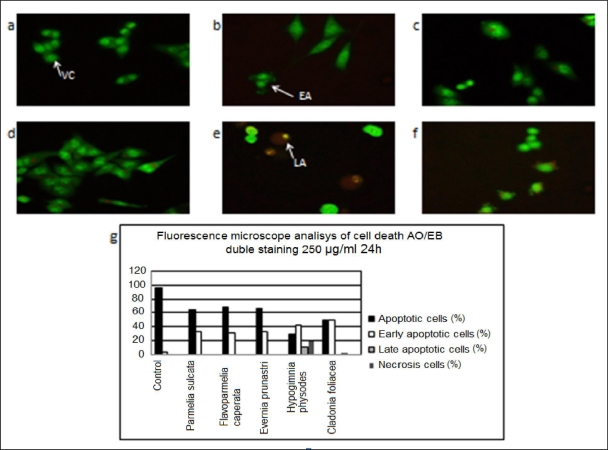
The effect of the lichen extracts on the apoptosis of HCT-116 cells after 24 h exposure monitored by the acridine orange/ethidium bromide staining: (a) Untreated, control cells; (b) Cells treated with Parmelia sulcata extract; (c) Cells treated with Flavoparmelia caperata extract; (d) Cells treated with Evernia prunastri extract; (e) Cells treated with Hypogymnia physodes extract; (f) Cells treated with Cladonia foliacea extract. Magnification on fluorescent microscope was 400×; (g) Grafic representation of obtained data. VC – viable cell, EA – early apoptotic cell, LA – late apoptotic cell.